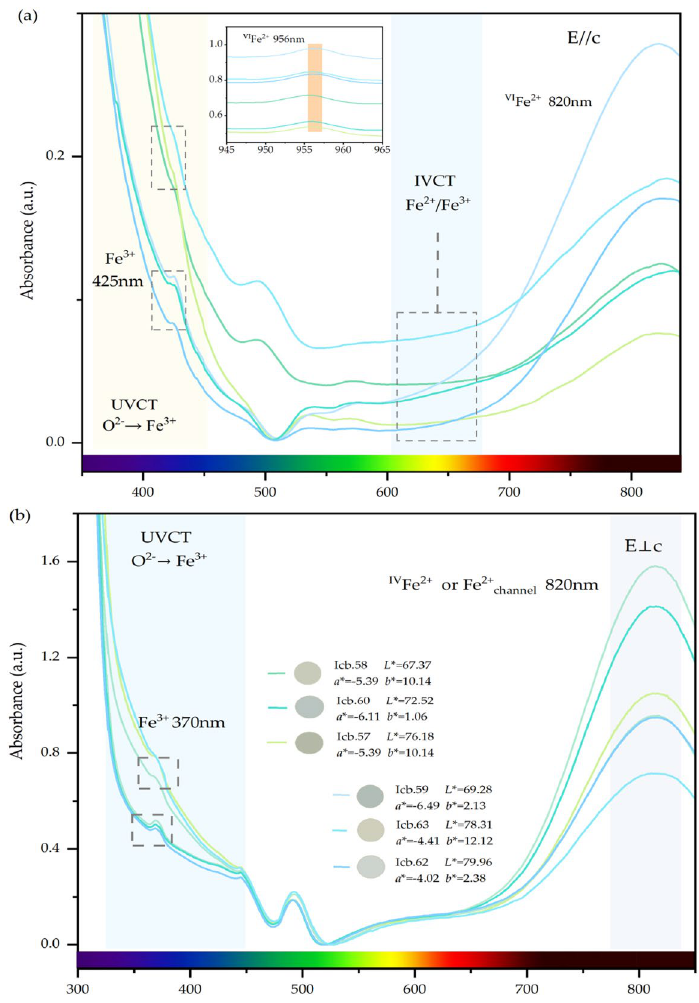
Figure 2. The polarized UV–vis spectra of beryl. ( a ) The E//c-polarization spectrum ( b ) The E ⊥ c-polarization